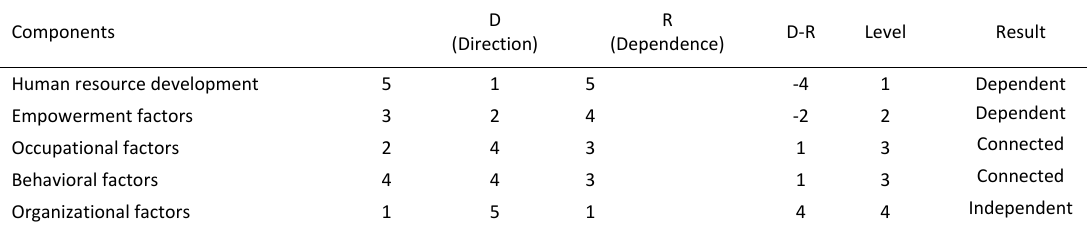
Table 7. Determining the levels of HRD components for SOE